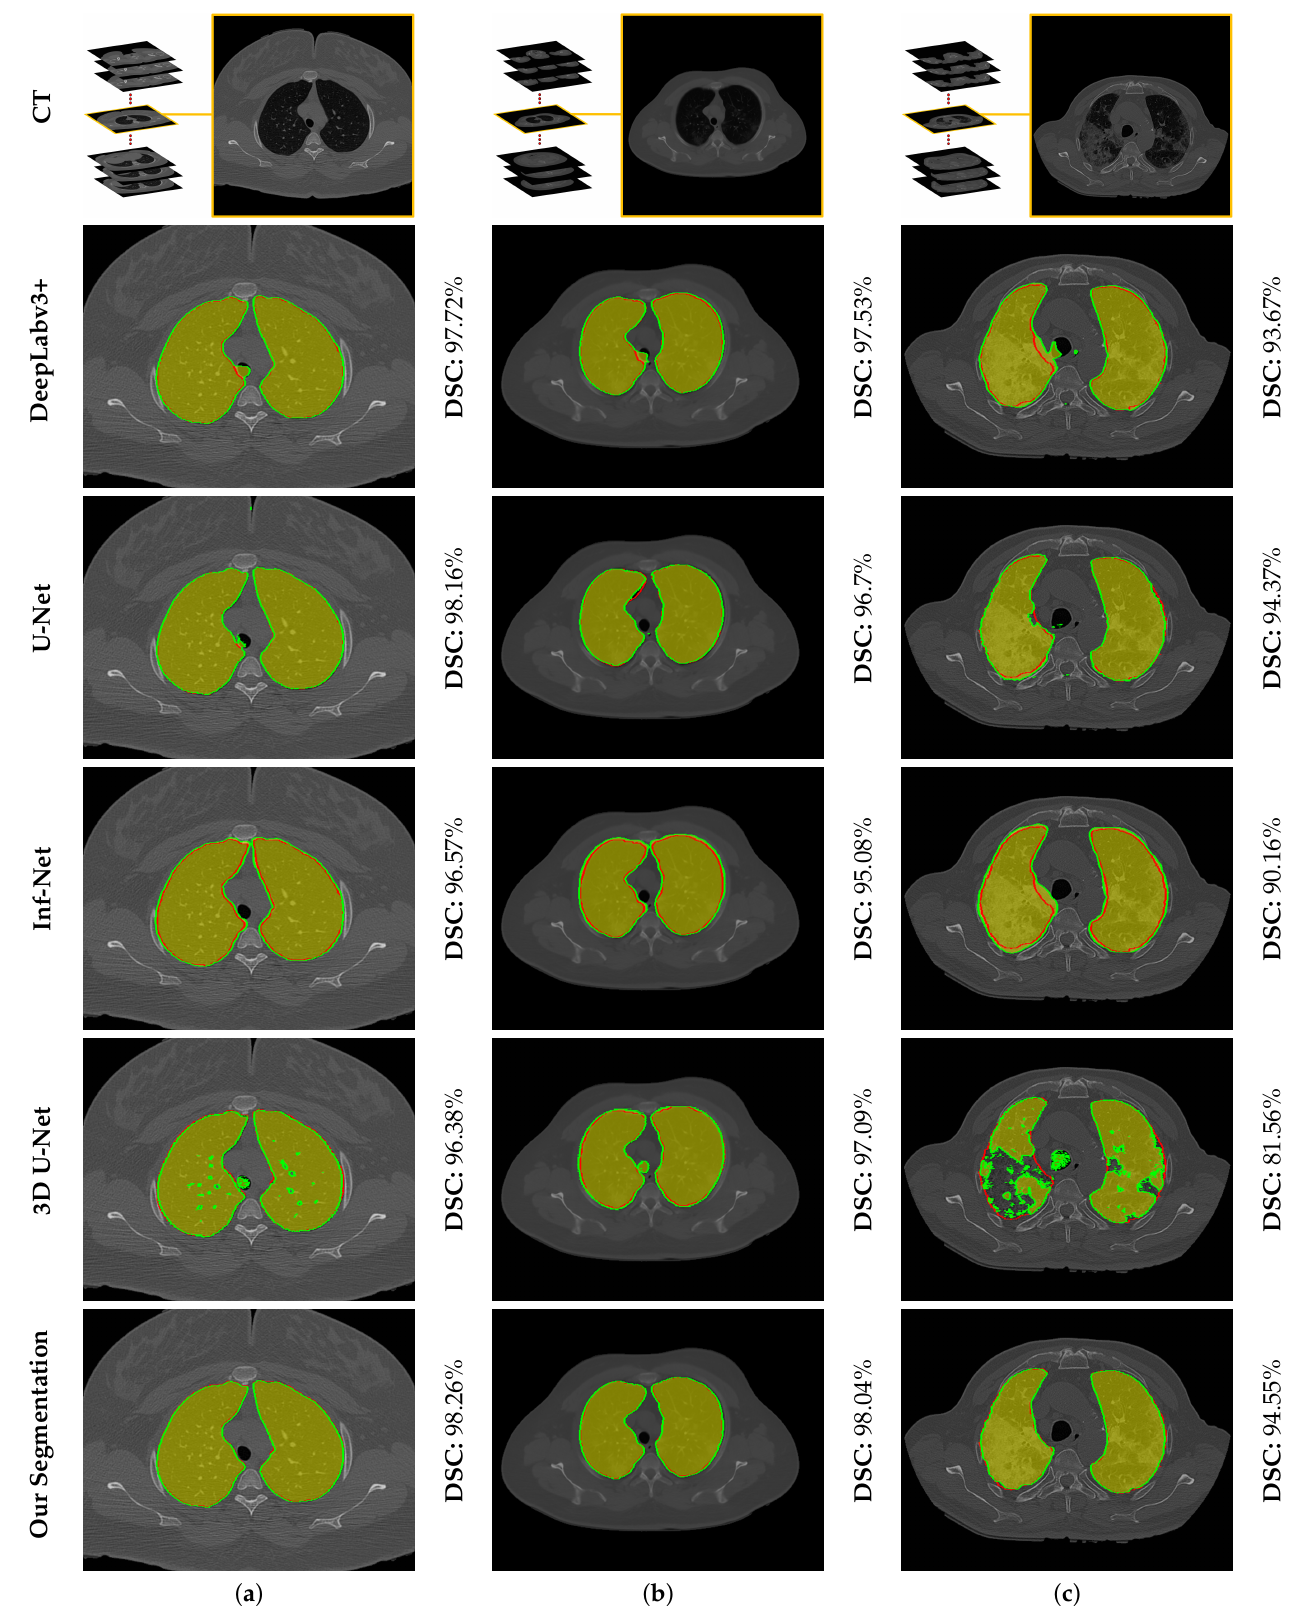
Figure 10. An illustrative example of the proposed segmentation compared to other deep learning approaches for ( a ) healthy/mild, ( b ) moderate, and ( c ) severe COVID-19 infected lung. Note that red border (green border or yellow region) refers to ground-truth